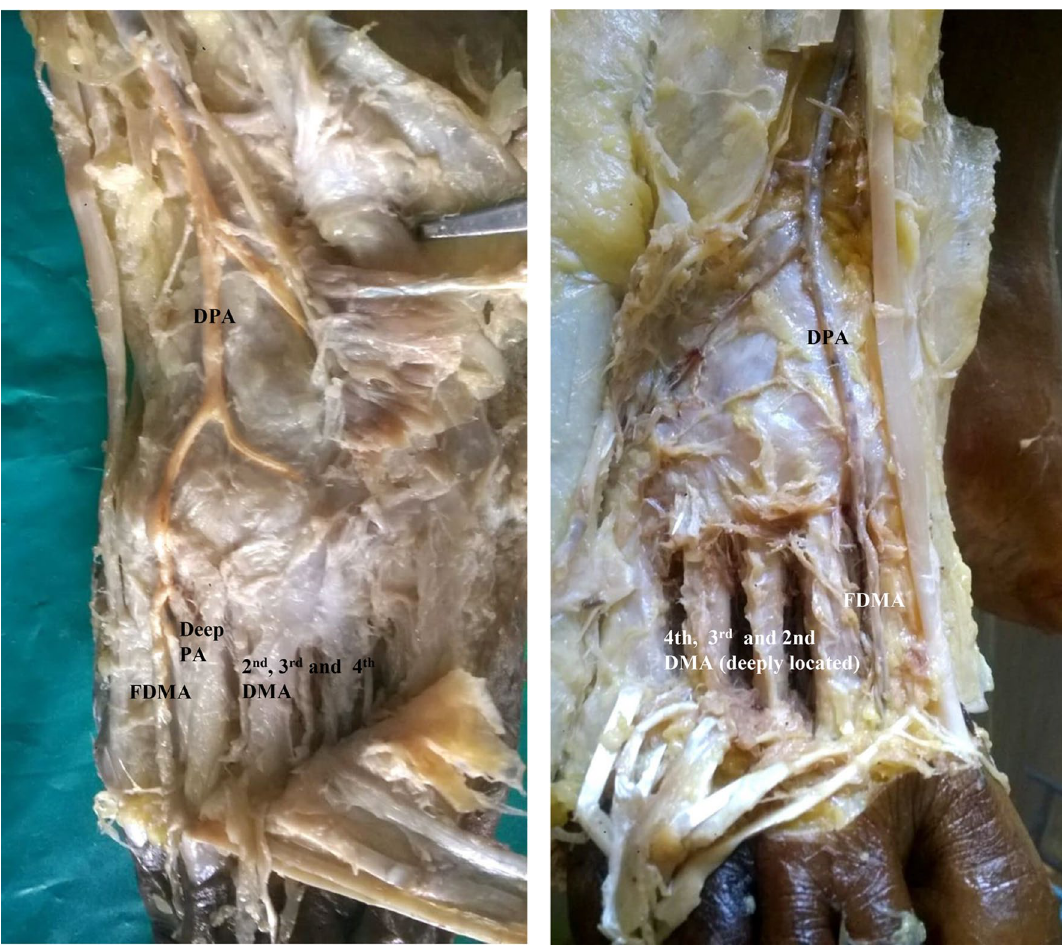
Figure 7. Dorsal metatarsal arteries arising from plantar arch. FDMA-First dorsal metatarsal artery, DMA- Dorsal metatarsal